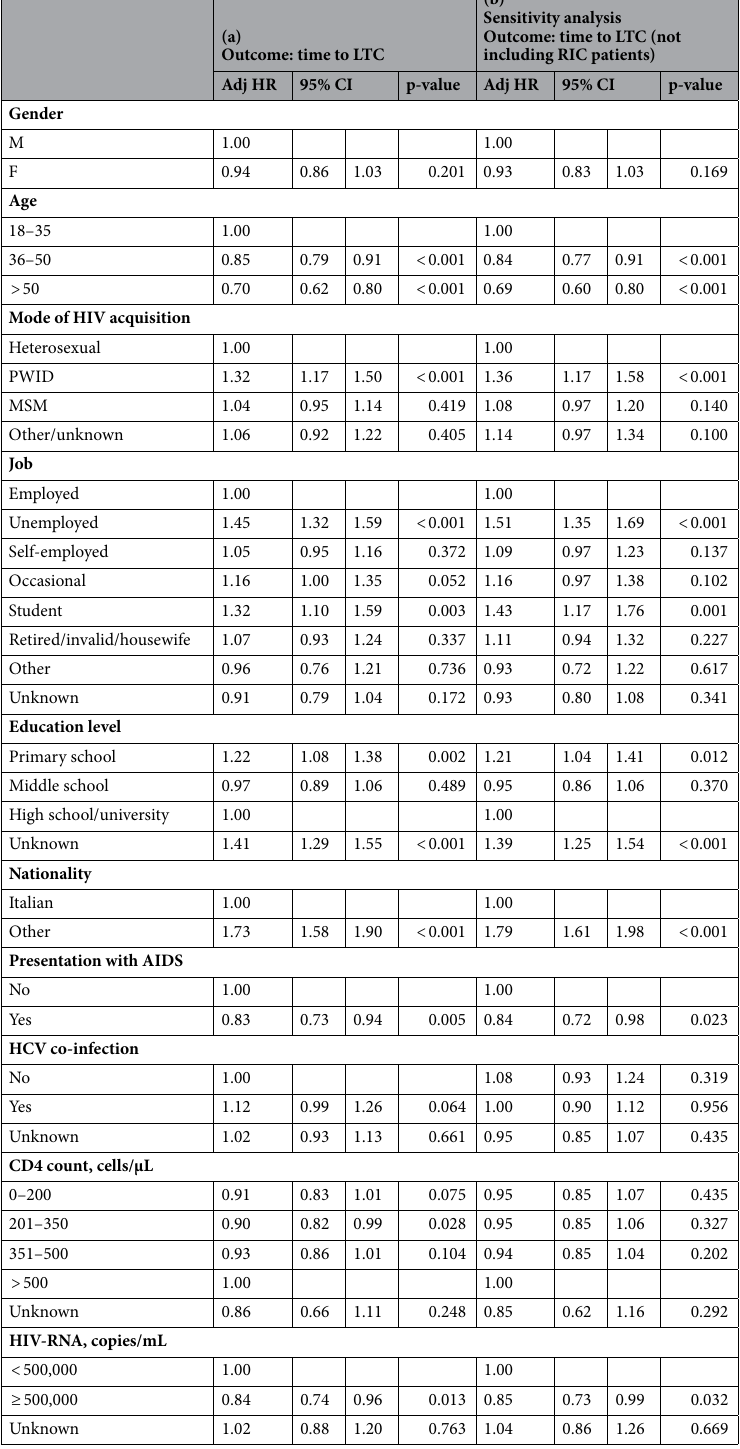
Table 2. Factors associated with time to LTC (a) including and (b) excluding RIC by means of Cox regression. Adj HR adjusted hazard